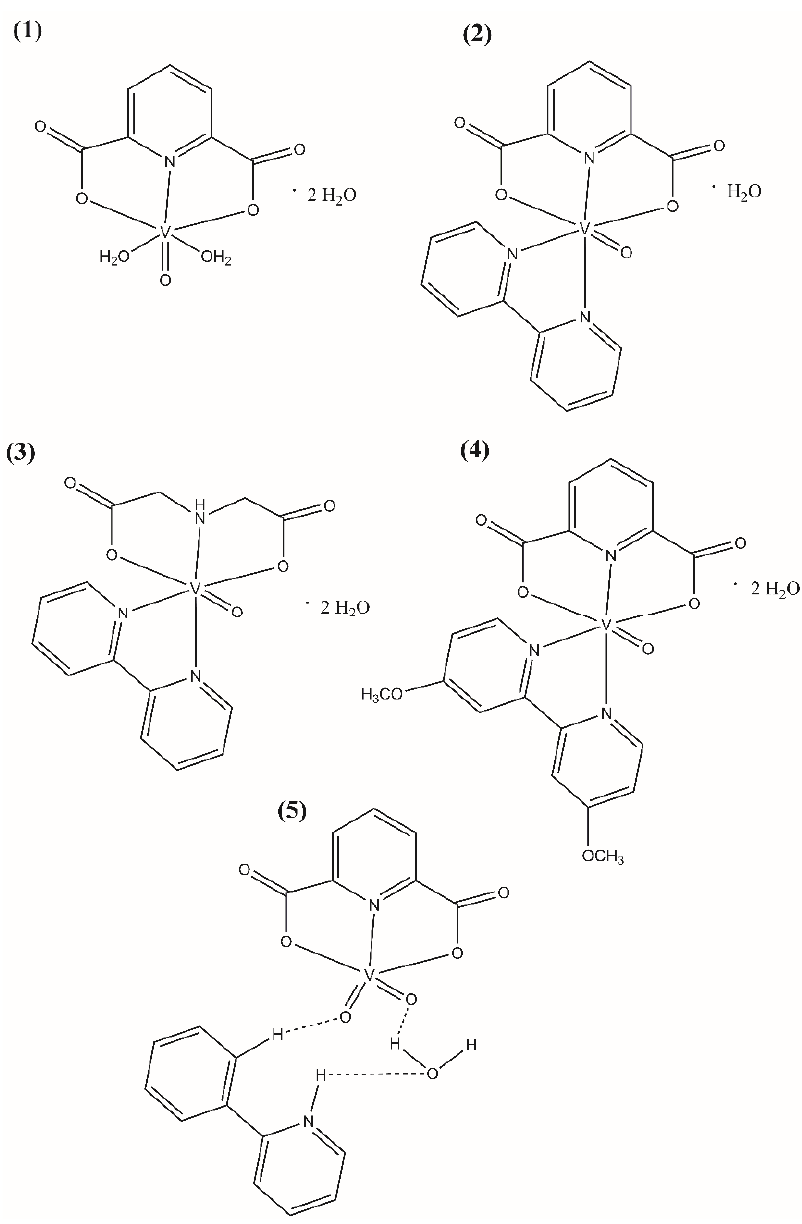
Figure 1. Molecular formulas of ( 1 ) [VO(dipic)(H 2 O) 2 ] ∙ 2 H 2 O, ( 2 ) [VO(dipic)(bipy)] ∙ H 2 O, ( 3 ) [VO(ida)(bipy)] ∙ 2 H 2 O, ( 4 ) [VO(dipic)(dmbipy)] ∙ 2 H 2 O, ( 5 ) [VOO(dipic)](2 ‐ phepyH) ∙ H 2